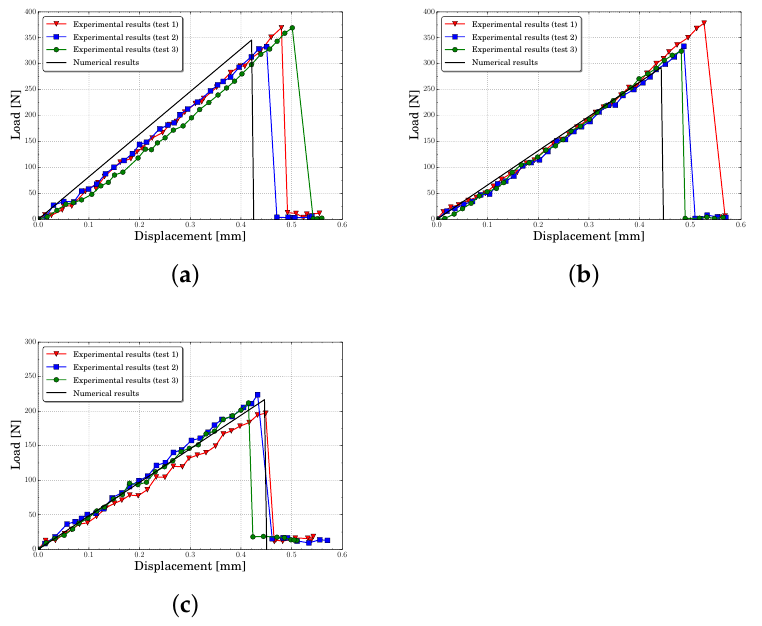
Figure 10. Load-displacement curves for centered notch specimens predicted for different notch lengths a ( a ) a = 6 mm, ( b ) a = 8 mm, ( c ) a = 10